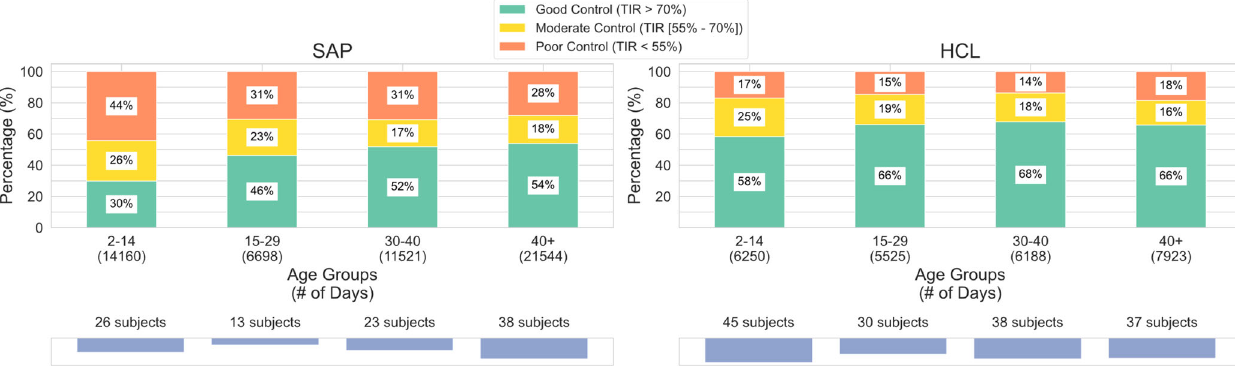
Fig. 5 “ SAP ” was duplicate image of “ HCL ” ; the fi gure should have appeared as shown below. The original article has been